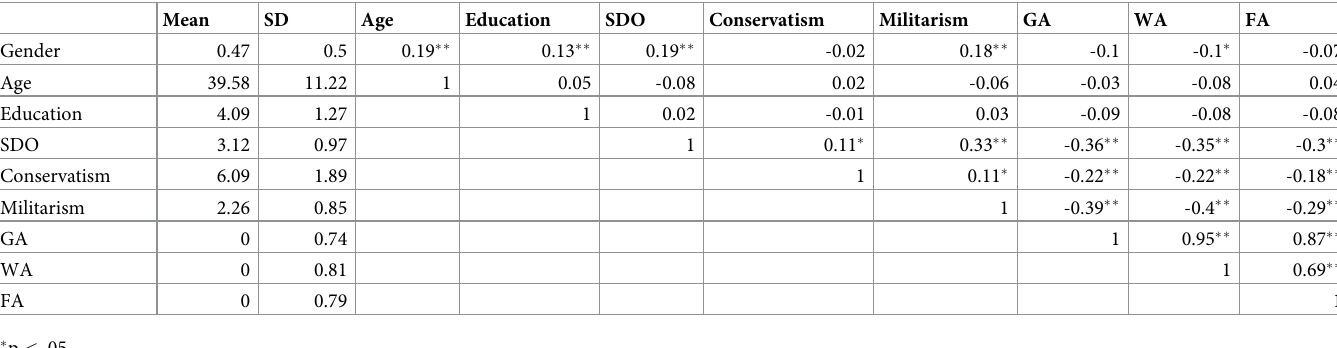
Table 1. Mean, standard deviation and correlation of each